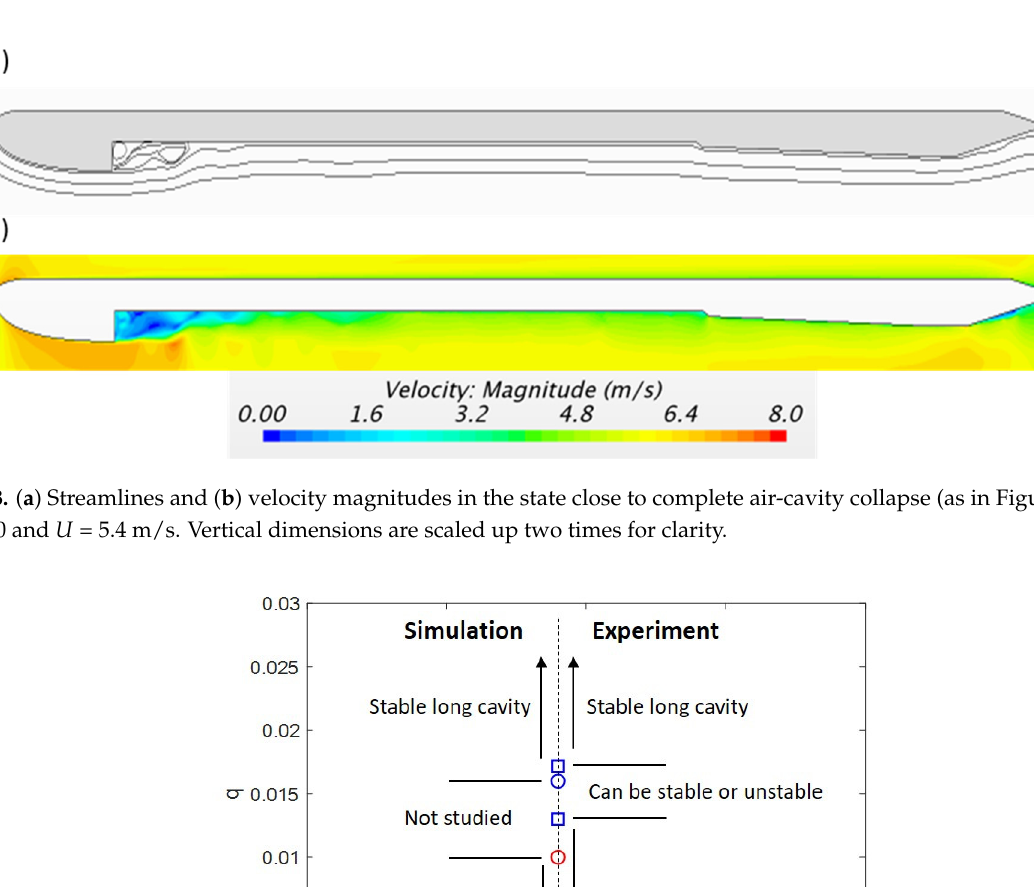
Figure 7. Air cavity in the collapsing process when air supply was reduced from 𝑞 = 0.016 to 0.010. Cavity shapes: ( a ) intermediate state, ( b ) close to the completely collapsed state.